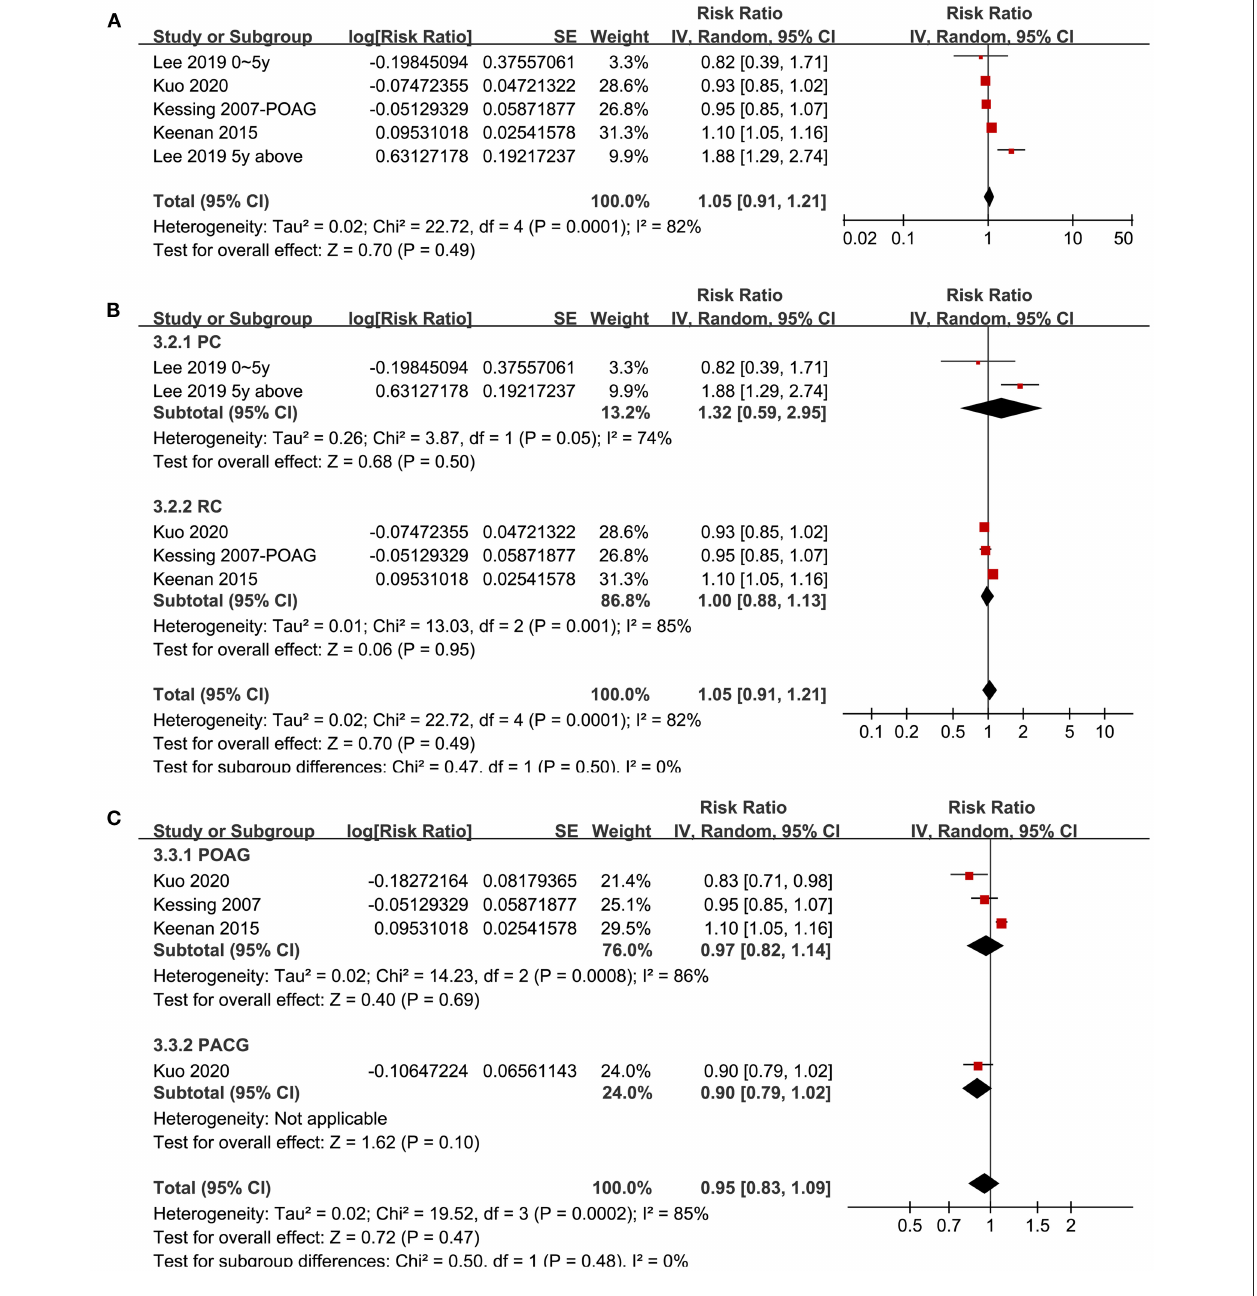
ε 4/ ε 4 genotype of ApoE , and deposition of amyloid- β